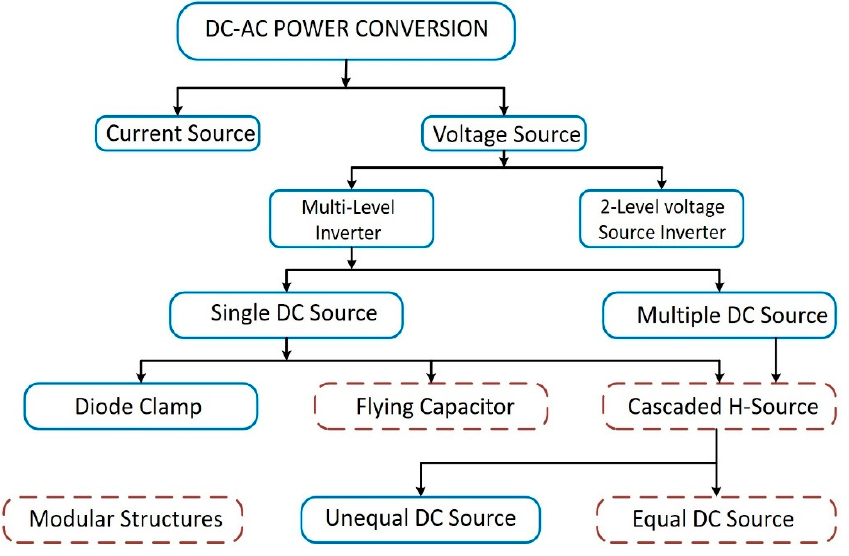
Figure 2. Voltage source or current source inverters.